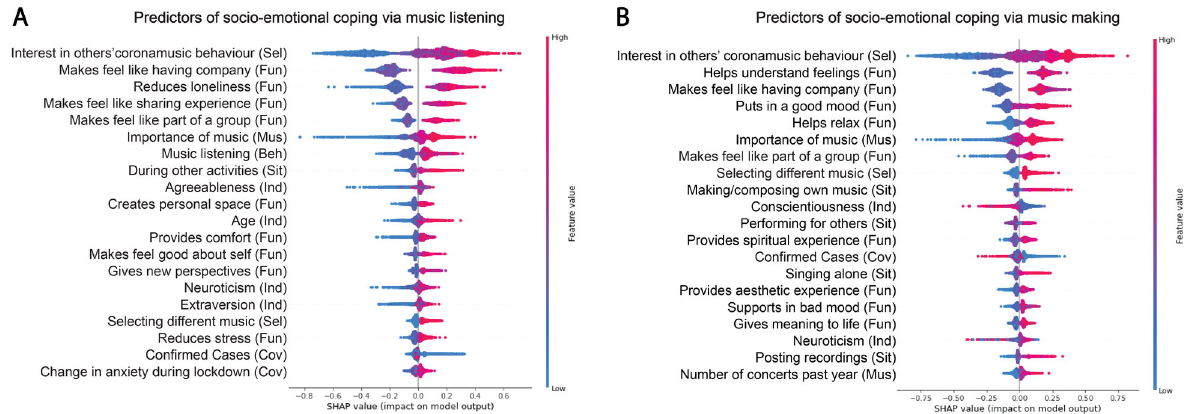
Fig. 2 Predictors of socio-emotional coping. Top 20 features predicting socio-emotional coping via ( A ) music listening, n = 4626, and ( B ) making music, n = 3023. Data points represent Shapley additive explanation (SHAP) values for every person on each of the top 20 most predictive features. SHAP values are measures of feature importance derived from game theory. The SHAP value for a given variable is a measure of the difference between two model predictions: one with the variable included and one without (Lundberg and Lee, 2017). Colour indicates whether a person scored high (red) or low (blue) on that variable. The x -axis shows the impact on the predicted socio-emotional coping score. Points to the right of 0 indicate that these feature scores increase the predicted socio-emotional coping score, whereas points to the left of the vertical black line decrease it. The greater the SHAP value (in absolute magnitude), the greater the impact on predicted socio-emotional coping score. Beh: Change in importance or frequency of behaviours during lockdown; Cov: COVID-19-related variable; Fun: Change in importance of functions of music listening/making during lockdown; Ind: individual characteristic (not music-related); Mus: music-related individual characteristic; Sel: Change in music selection during lockdown; Sit: Change in likelihood of situation of music